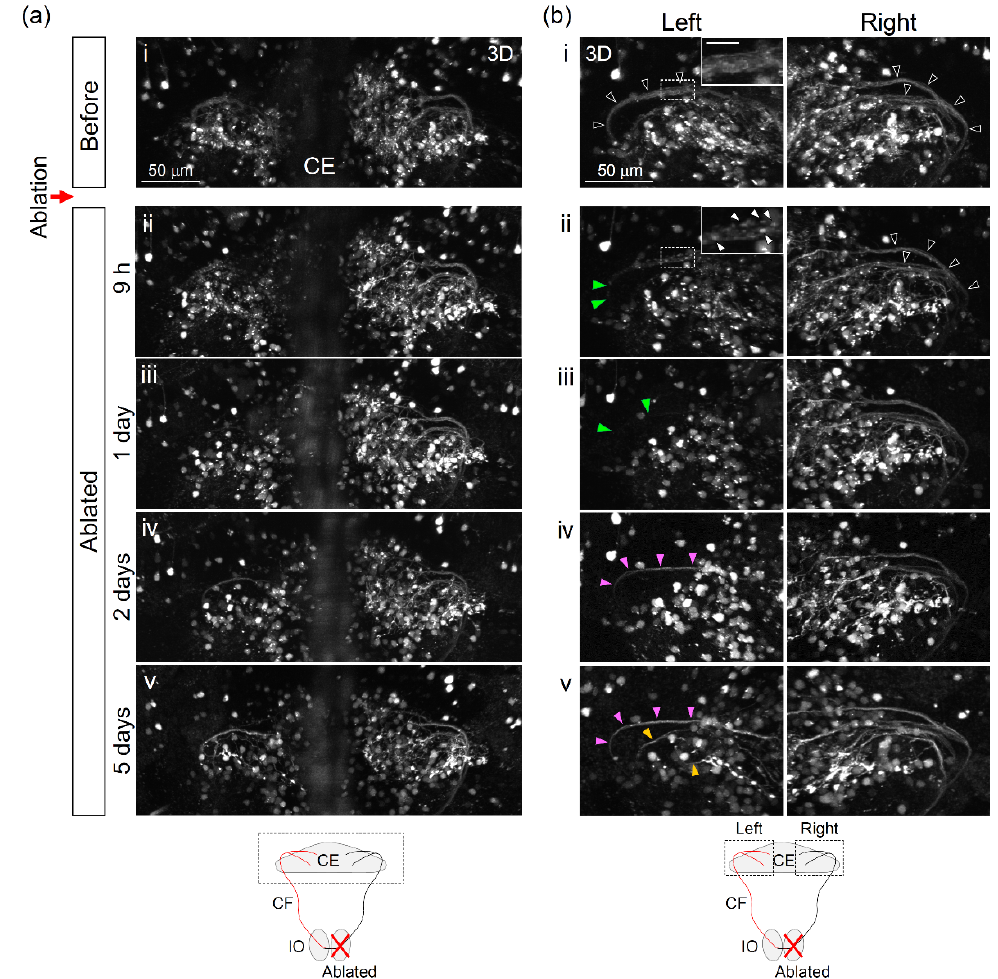
Figure 4. Structural changes of climbing fibers (CFs) in the cerebellar region induced by the two-photon laser ablation of the inferior olive. ( a , b ) Three-dimensional dorsal view of climbing fibers. The area of observations is shown by the dotted line in the schematic diagram. Before ablation: i, after ablation: ii (9 h), iii (1 day), iv (2 days), and v (5 days). ( b ) A similar region as (a), but the orientation is slightly different: A high-magnification image is inserted in the upper right corner in ( b-i ) (before) and ( b-ii ) (after 9 h). Scale bar: 10 µ m. Black arrowheads in ( b-i ) indicate the bundle of CFs. Green arrowheads in ( b-ii,iii ) indicate the defected CFs after laser ablation. Red and yellow arrowheads ( b-iv,v ) indicate newly emerged CFs.